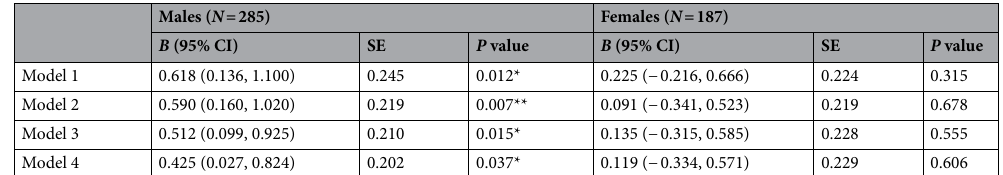
Table 2. Regression coefficients showing cross-sectional associations between depressive symptoms and pericardial fat adjusted for body surface area. SE = robust standard errors to adjust for heteroscedasticity. * p < 0.05, ** p < 0.01, *** p < 0.001. Model 1 adjusted for age and grade of employment. Model 2 adjusted for age, grade of employment and waist to hip ratio. Model 3 adjusted for age, grade of employment, waist to hip ratio, smoking, LDL cholesterol, HDL cholesterol, triglycerides, systolic blood pressure and HOMA-IR. Model 4 adjusted for age, grade of employment, waist to hip ratio, smoking, LDL cholesterol, HDL cholesterol, triglycerides, systolic blood pressure, HOMA-IR and IL-6. CI confidence interval, HDL high-density lipoprotein, HOMA-IR insulin resistance, LDL low-density lipoprotein, IL-6 interleukin-6.